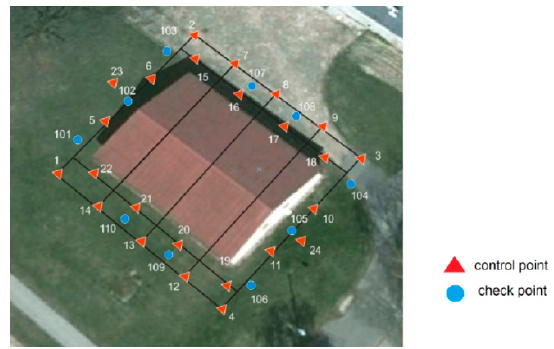
Figure 4. Photogrammetric terrestrial network around the building.